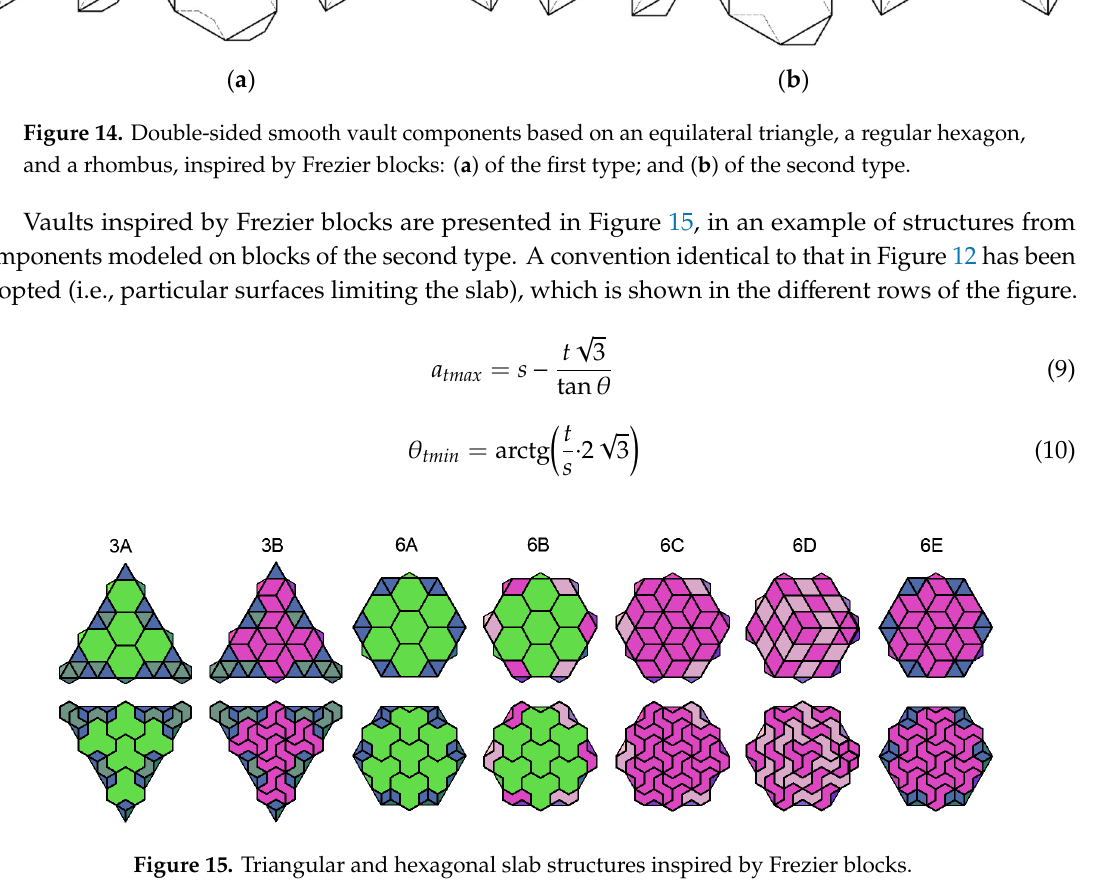
Figure 15. Triangular and hexagonal slab structures inspired by Frezier blocks.